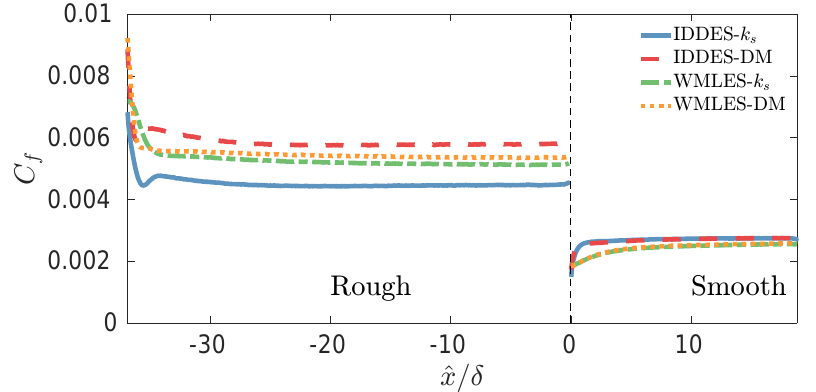
Figure 3. Skin friction coefficient development over rough and smooth